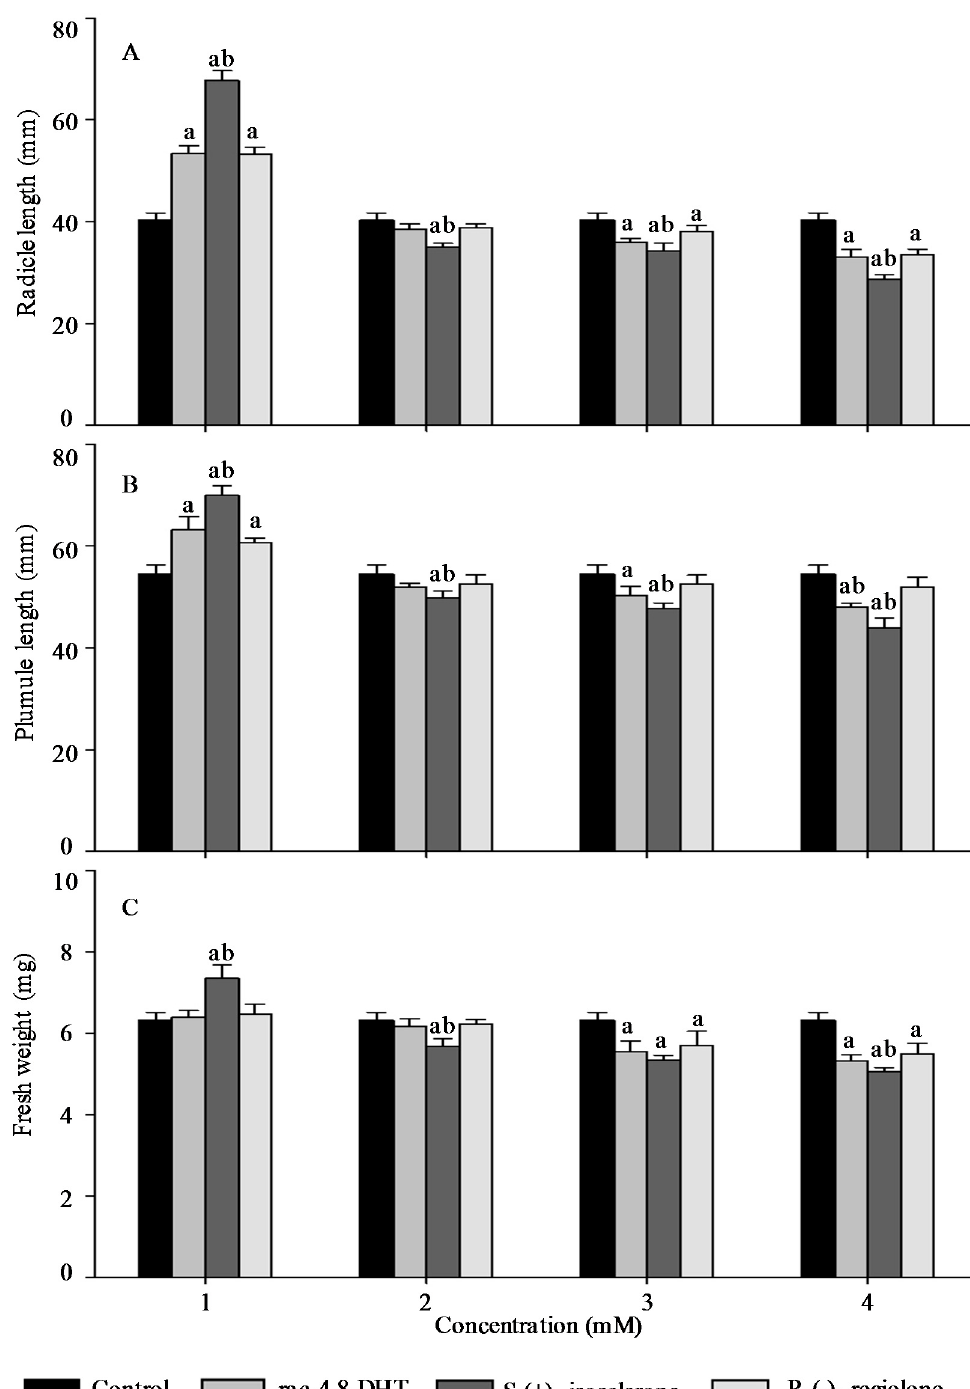
Figure 5. Effect of rac-4,8-DHT, S -(+)-isosclerone, and R -( − )-regiolone at different concentrations on radicle length ( A ); plumule length ( B ); and fresh weight ( C ) in onion. a denotes significant difference between control and treatments ( p < 0.05); b denotes significant difference among rac-4,8-DHT, S -(+)-isosclerone and R -( − )-regiolone ( p < 0.05).